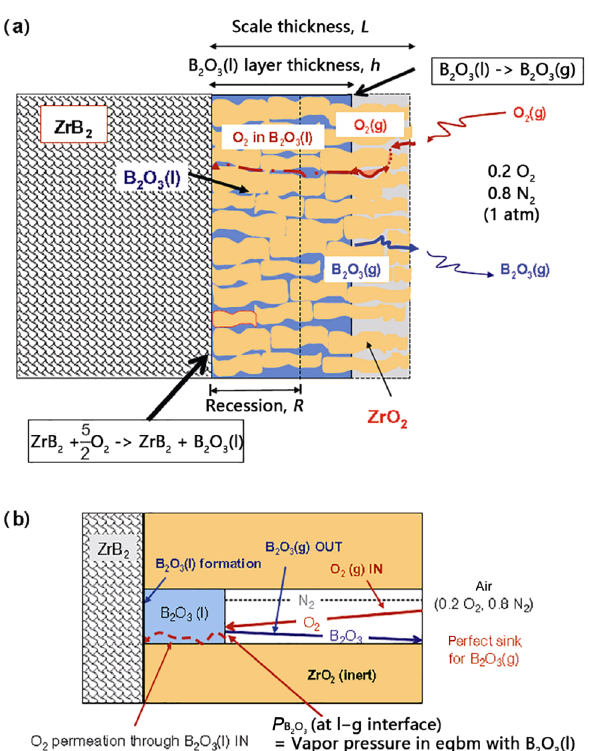
Fig. 11 Schematic diagram of mechanisms involved oxidation of ZrB 2 in air in the temperature range of 1000–1800 ℃ (a); schematic of the mechanistic steps considered in the oxidation model (b) developed by Parthasarathy et al. Reproduced with permission from